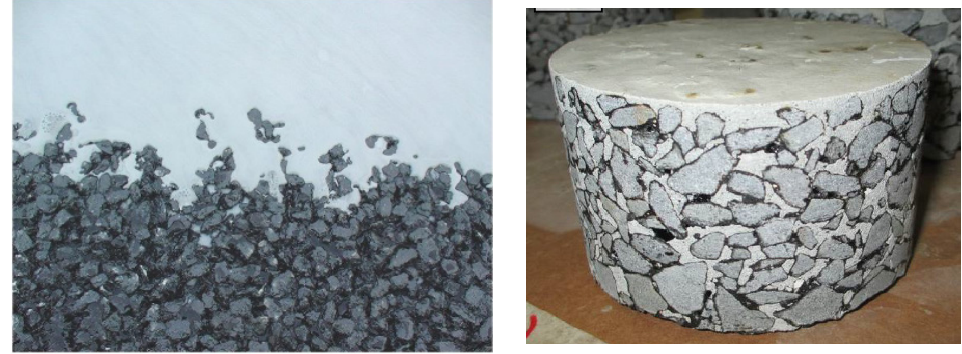
Figure 1. Grouted Macadam (semi-flexible pavement surface/mixtures) [4,45,48].